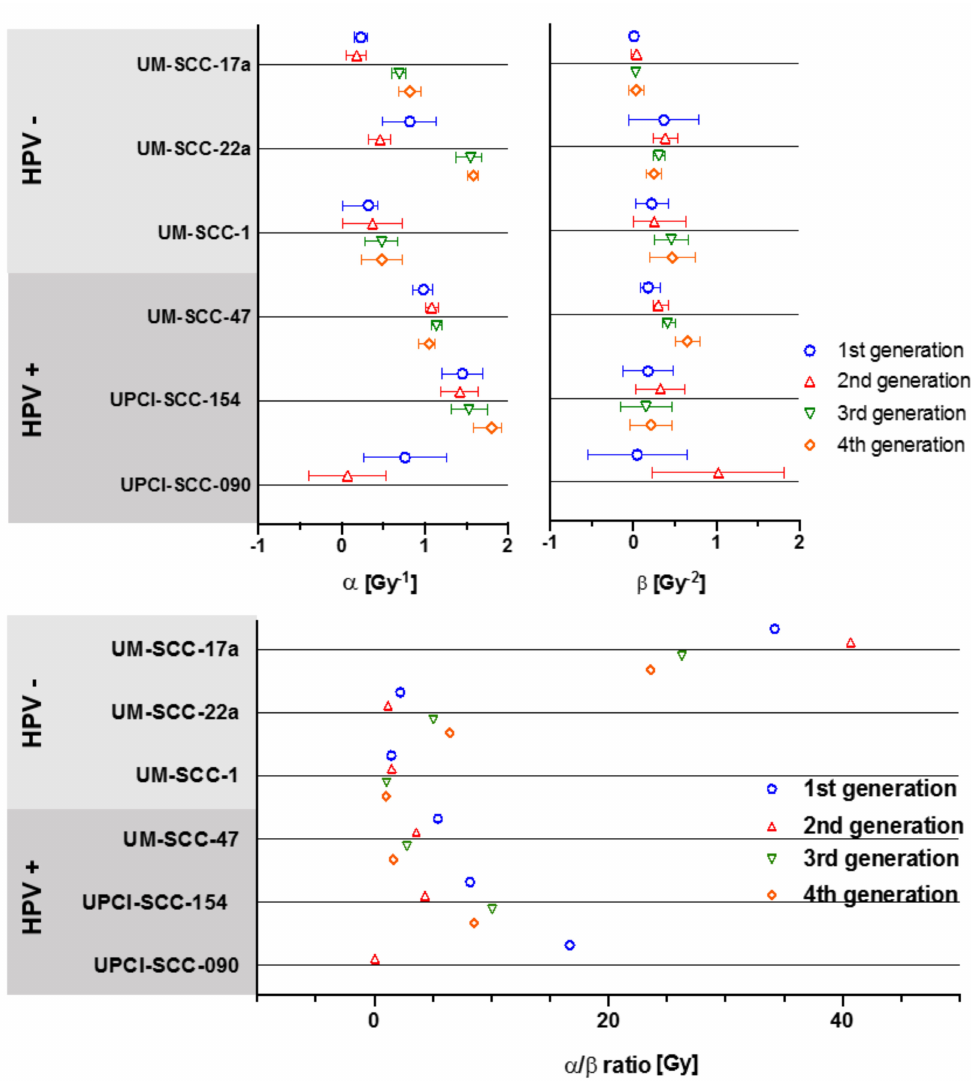
Figure 5. Changes in α , β and α / β ratios for 4 generations of each cell line. Error bars presented as 95%